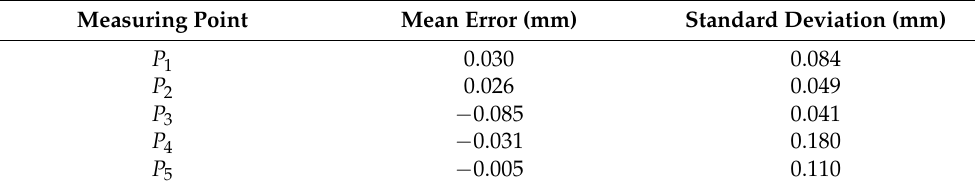
Figure 9. Experimental results of a cantilever beam under static loading: ( a ) full-field deflection curves of the beam, containing 6 different loads; ( b ) comparison of results obtained by dial indicator and video deflectometer, including 11 loading and unloading stages. Table 1. The mean errors and standard deviations at five measurement locations.